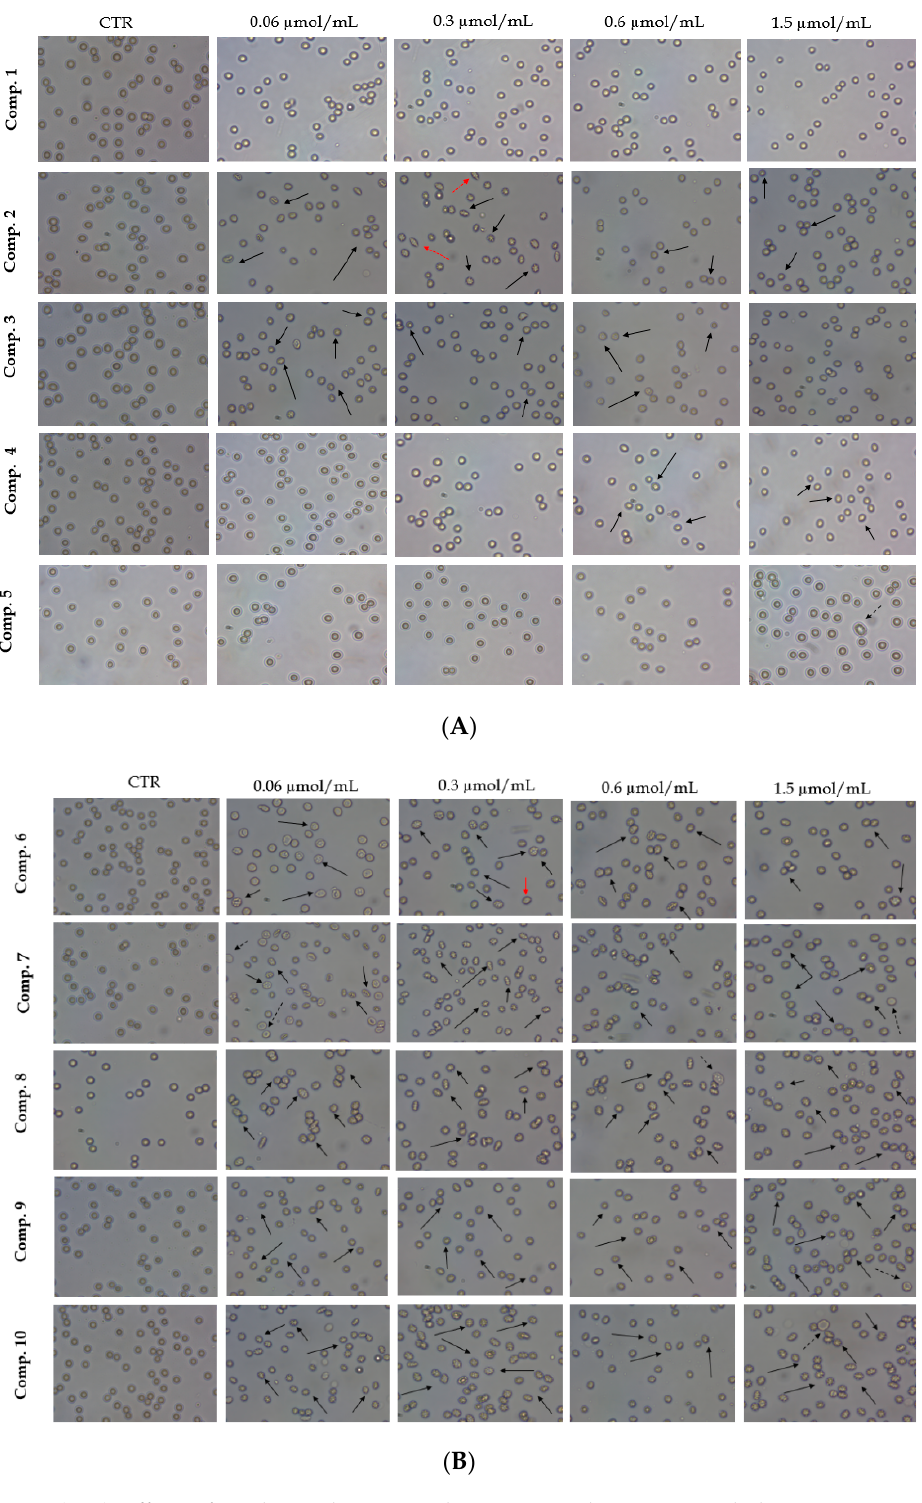
Figure 3. ( A,B ). Effects of synthesized compounds 1 – 10 on erythrocytes morphology. Representative phase-contrast images are shown (magnification of 400 times), echinocytes are marked with black arrows, ovalocytes are marked with black dashed arrows and stomatocytes are marked with red arrows. In these studies, metformin was used as a reference compound. It was found to induce the formation of echinocytes. At higher concentrations (1.5 µmol/mL), RBC membrane deformability could also be observed which might be attributed to eryptosis (Figure S2, Supplementary Materials).